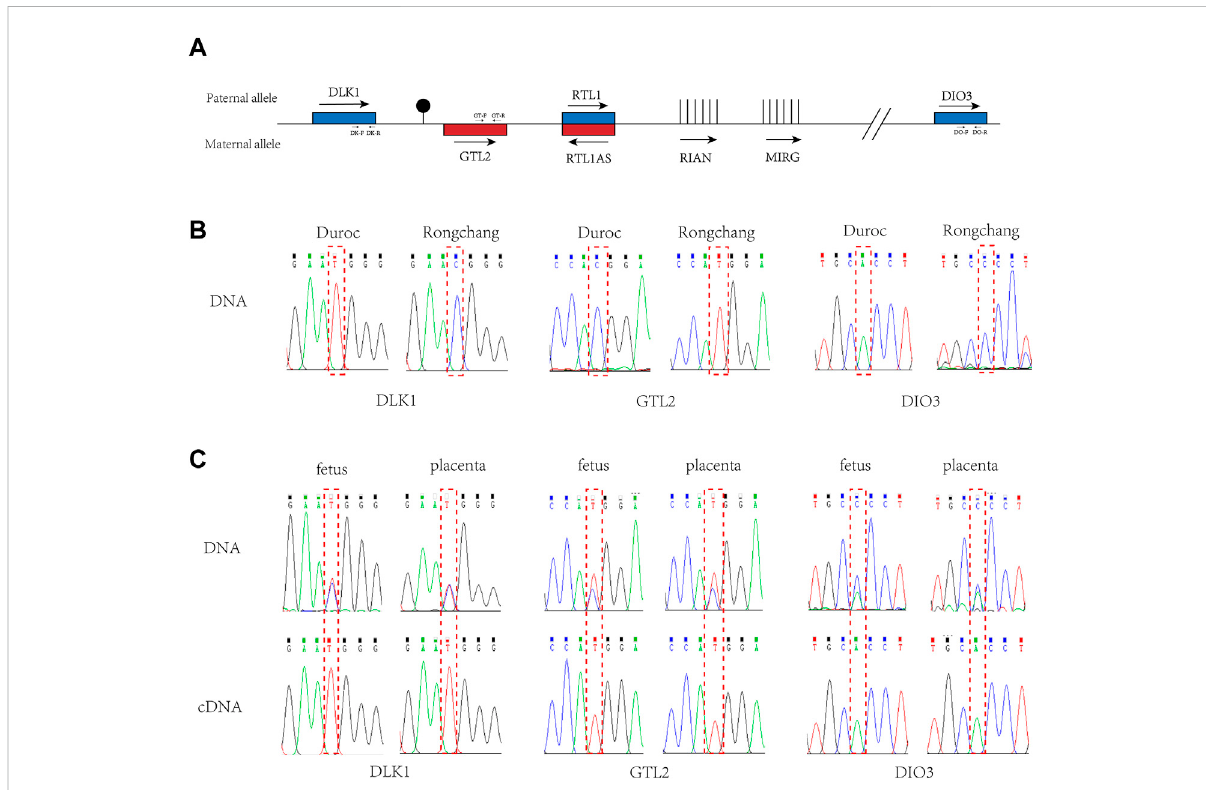
FIGURE 2 Imprinted expression of DLK1, GTL2, and DIO3 in the DLK1-DIO3 region. (A) . Structure diagram of the DLK1 - DIO3 imprinted domain. Blue squares represent paternal expression imprinted genes, and red squares represent maternal expression imprinted bases. The arrow direction is the transcription direction, and vertical lines represent non-coding RNA. Primer positions and directions are marked on the corresponding genes. (B) . Validation of SNPs in Rongchang and Duroc pig genomes. (C) . Allele-speci fi c expression analysis of DLK1 , GTL2 , and DIO3 in the fetus and placenta of the three crossbred pigs. The above sequencing results used the genome as a template for PCR, and the following sequencing results used cDNA as a template for PCR. The red-dashed boxes indicate SNP